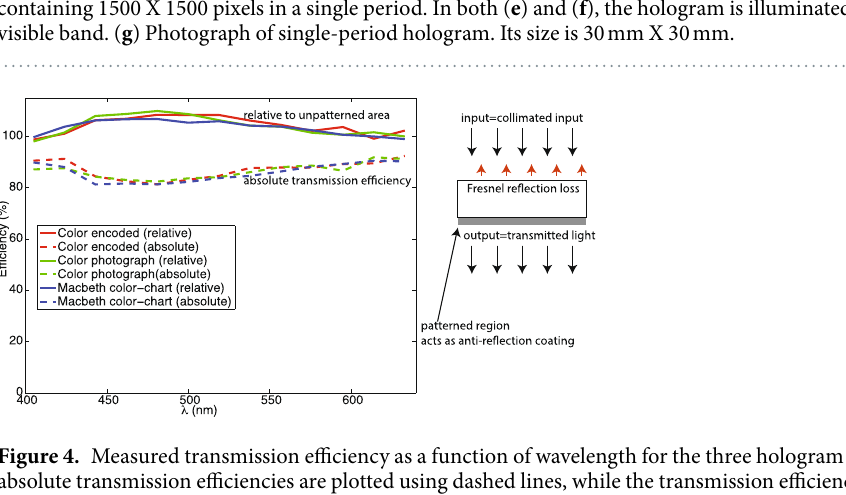
a photograph of 3 X 3 periods of the projected image reflected off an opaque white screen are shown in Figs. 3(c), (d) and (e), respectively. Note that the photograph indicates good color reproduction even at an oblique viewing angle. Photographs at many more viewing angles are shown in Fig. S11. In order to increase the resolution of the projected image, we also designed and fabricated another device containing 1500 X 1500 pixels (Fig. S9). To reduce fabrication time, only one period of this device was fabricated and characterized. A photograph of the pro- jected image reflecting off an opaque white screen is shown in Fig. 3(f). A photograph of this single-period hol- ogram is shown in Fig. 3(g). This result coupled with the simulated image of a single-period hologram (Fig. S9) confirms that periodic boundary conditions are not a limitation of our design method. In all cases in Fig. 3, the devices were illuminated with the white collimated backlight. We also measured the transmission efficiency of our devices. Note that transmission efficiency was used earlier as a figure of merit for metalens-based holograms 9 . First, an aperture of the same size as one period of the holo- gram was placed directly in front of the hologram (see Fig. S8). The absolute transmission efficiency was defined as the ratio of the power transmitted through the hologram to that incident on the hologram. We also measured the relative transmission efficiency, which is defined as the ratio of the power transmitted through the hologram to that transmitted through an unpatterned region. The results, as a function of illumination wavelength are plot- ted in Fig. 4 (dashed lines show absolute values, while solid lines show relative values). The illumination was the super-continuum source coupled to a tunable filter. A bandwidth of 10 nm was used for each wavelength sample for the transmission-efficiency measurements. The average absolute transmission efficiencies (from 405 nm to 633 nm) are 87%, 87% and 86% for the color-encoded hologram, the photograph hologram and the Macbeth hol- ogram, respectively. Some of the relative efficiencies are higher than 100% indicating that the hologram pattern